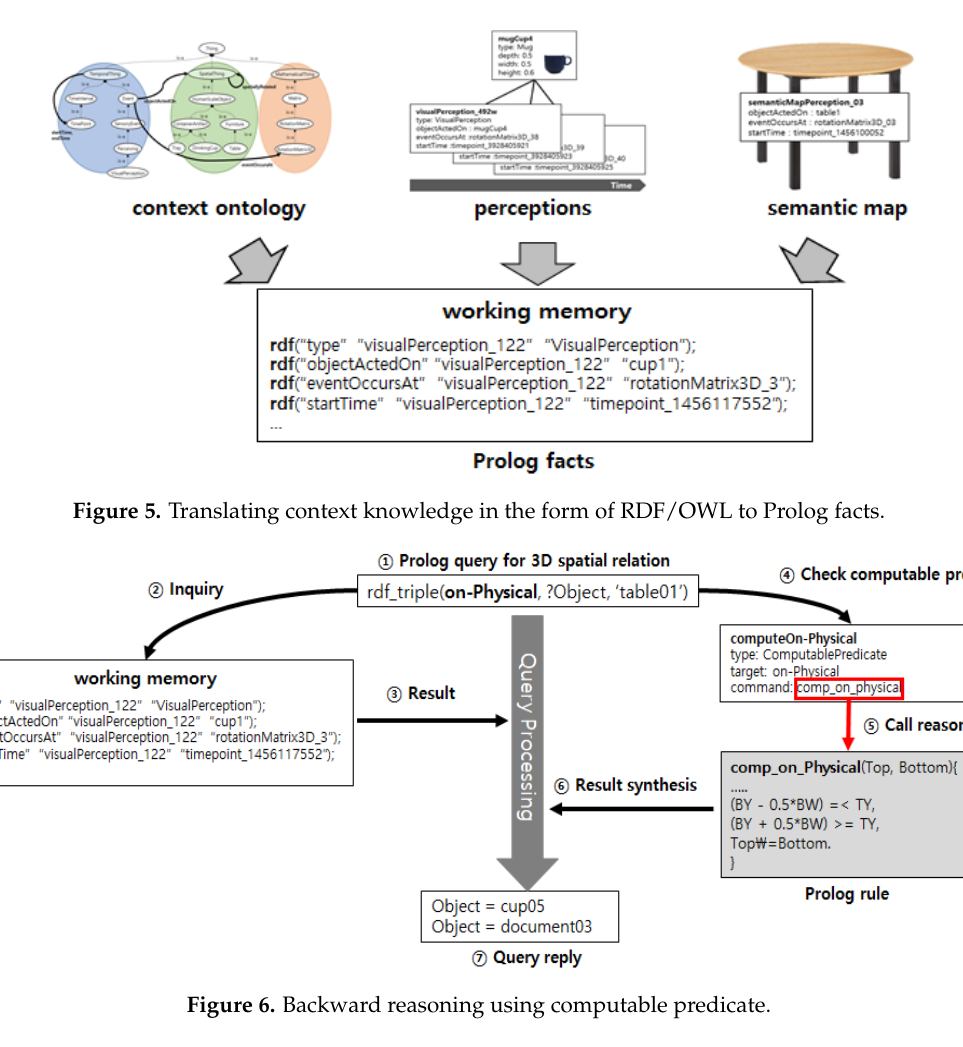
Figure 6. Backward reasoning using computable predicate.